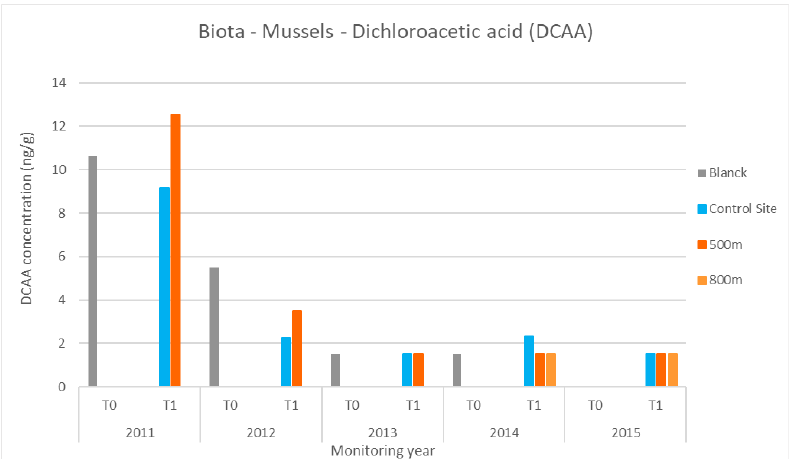
Figure 12. DCAA concentrations in mussel samples collected from 2010 to 2015 at sites located near the LNG terminal and at control site in the Northern Adriatic Sea. Table 3. Bioaccumulation ratios (BARs) for chloroform, MCAA, and DCAA resulted during moni- toring activities of an LNG terminal in the Northern Adriatic Sea. BAR values are shown in Table 3.